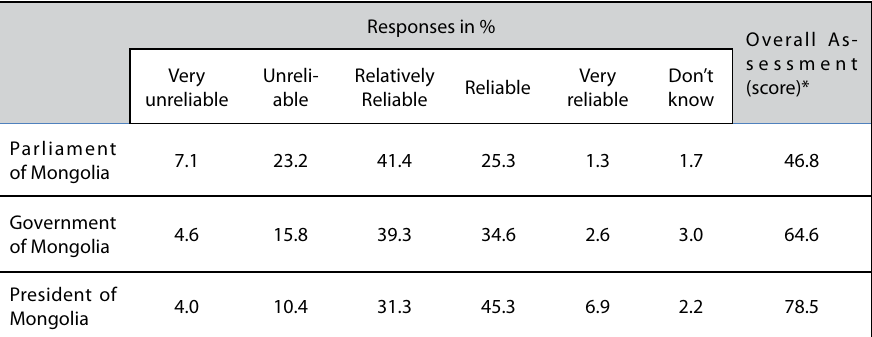
Table 6. Citizens’ Trust in the State Institutions Responses in